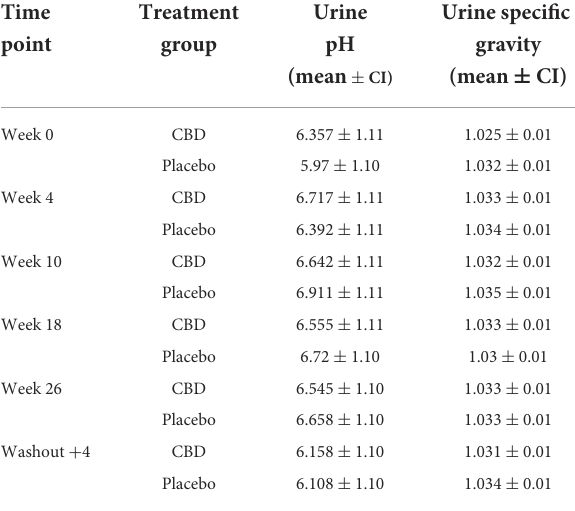
TABLE 1 Mean and 95% confidence intervals of urine pH measured by dipstick, and urine specific gravity measured by refractometer, in dogs dosed with CBD and